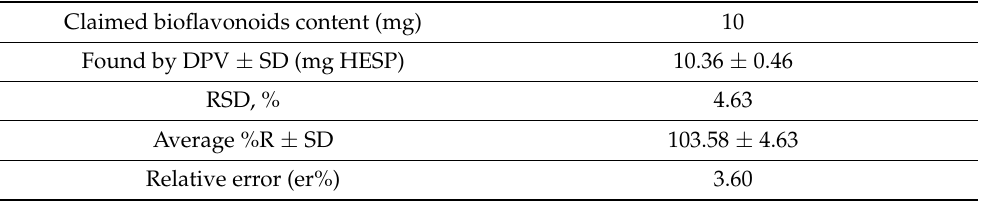
Figure 9. Differential pulse voltammograms recorded at H type PGE for 10 mL diluted dietary supplement capsules solution in BRB pH 1.81 before and after successive additions of 0.025 mL 4.00 × 10 − 4 mol/L HESP stock solution and the corresponding calibration graph (inset). ( a ) Differential pulse voltammograms recorded ( b ) the corresponding calibration graph. Table 5. The results obtained for the DPV at H type PGE assessment of the bioflavonoids content, expressed as mg HESP, from Good Routine C-Your-Immunity dietary supplement capsules.